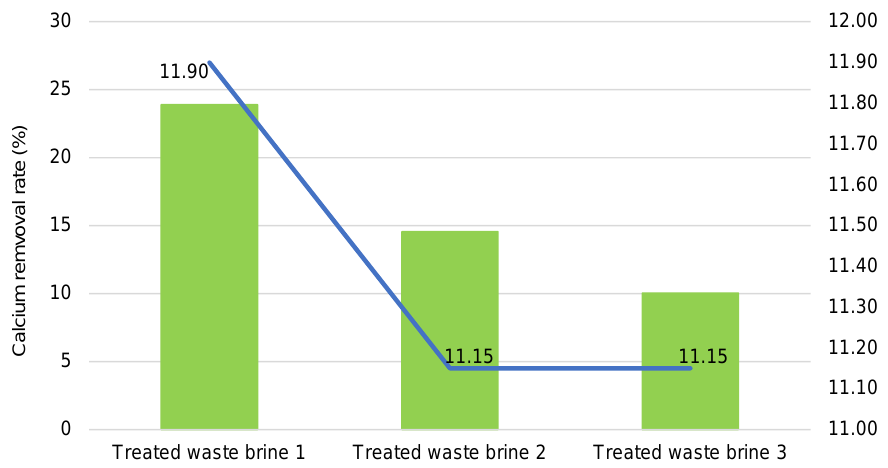
Figure 4. Removal rate of calcium ions from waste brine at a pH above 11.